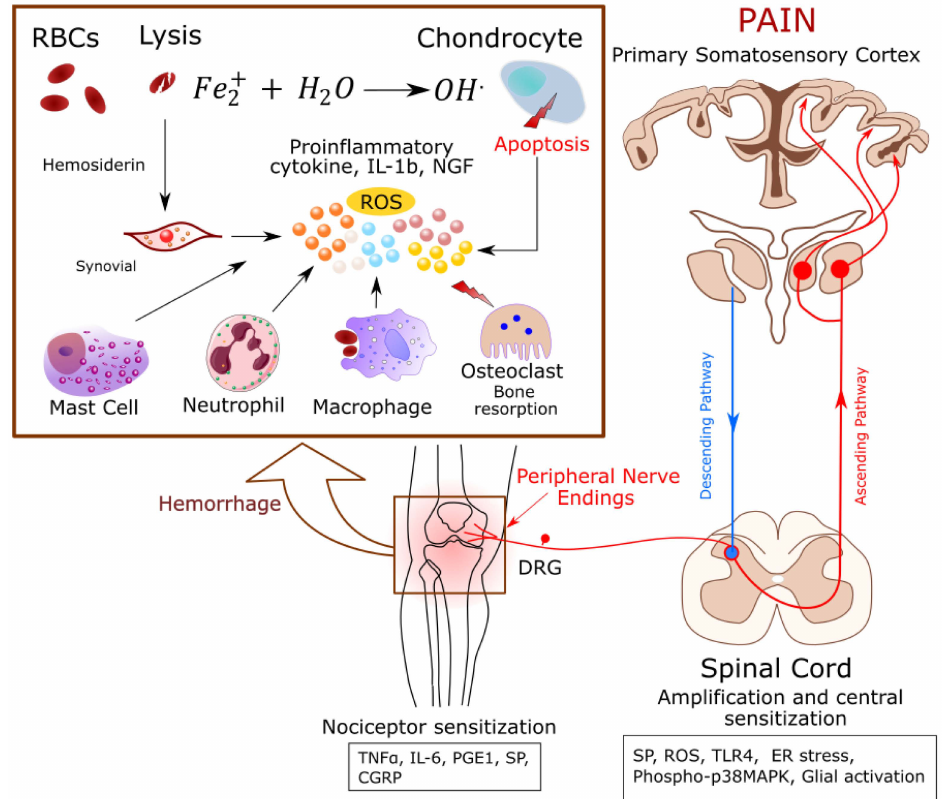
Figure 1. Proposed mechanism(s) of pain in Hemophilia: Joint bleeding releases cell free heme and proinflammatory cytokines leading to synovitis. Red cell derived iron (Fe 2+ ) causes oxidative stress and chondrocyte apoptosis. Inflammation activates Receptor Activator of NF- κ B Ligand (RANK-L)-RANK-Osteoprotegin (OPG)-pathway, resulting in bone resorption by osteoclasts. This microenvironment of inflammation, cell damage, and oxidative stress activates nociceptors on the nerve fibers, which release neuropeptides and transmit the action potentials to the central nervous system (CNS) leading to the perception of pain. Abbreviations: CGRP: Calcitonin gene-related peptide, DRG: Dorsal root ganglion, ER stress: Endoplasmic reticulum stress, NGF: Nerve growth factor, PGE1: Prostaglandin E1, RBCs: Red blood cells, ROS: Reactive oxygen species, SP: Substance P, TLR4, Toll like receptor 4, TNF- α : Tumor necrosis